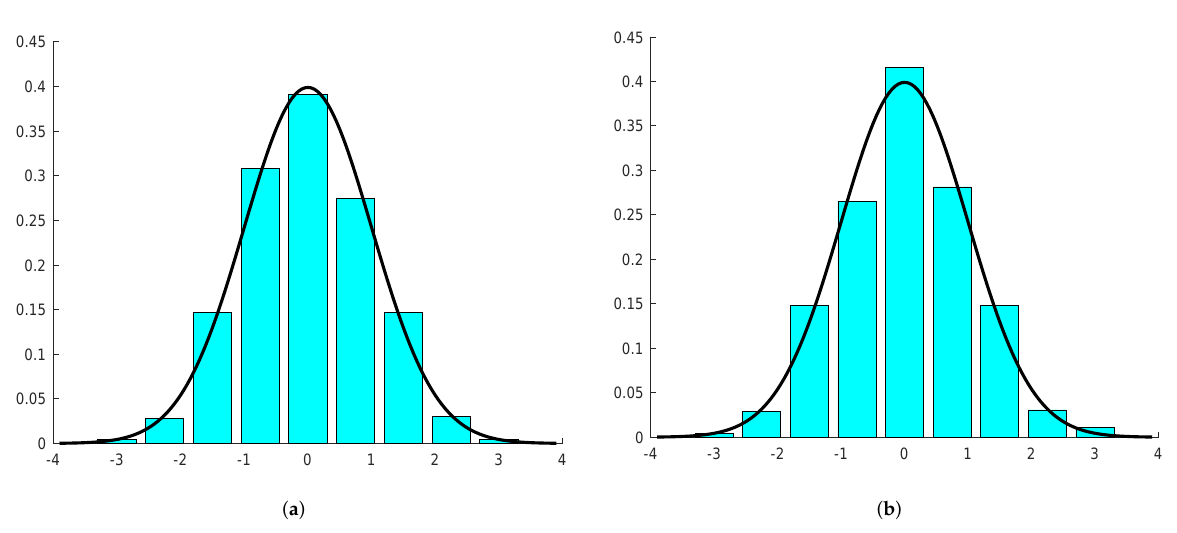
Figure 2. The joint histograms of the first two coordinates in Examples 3 and 4. ( a ) Histogram for Example 3; ( b ) Histogram for Example 4.